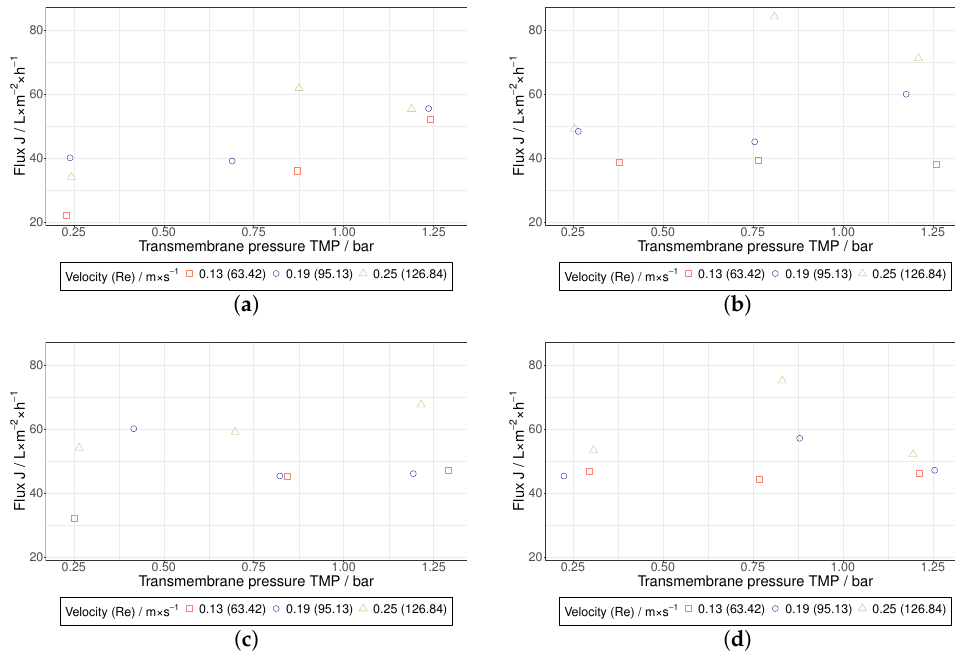
Figure 7. Stationary flux of the TFF treatment of HIV VLPs over the TMP for the different MWCOs; ( a ) 100kDa, ( b ) 300kDa, ( c ) 500kDa, ( d ) 750kDa.